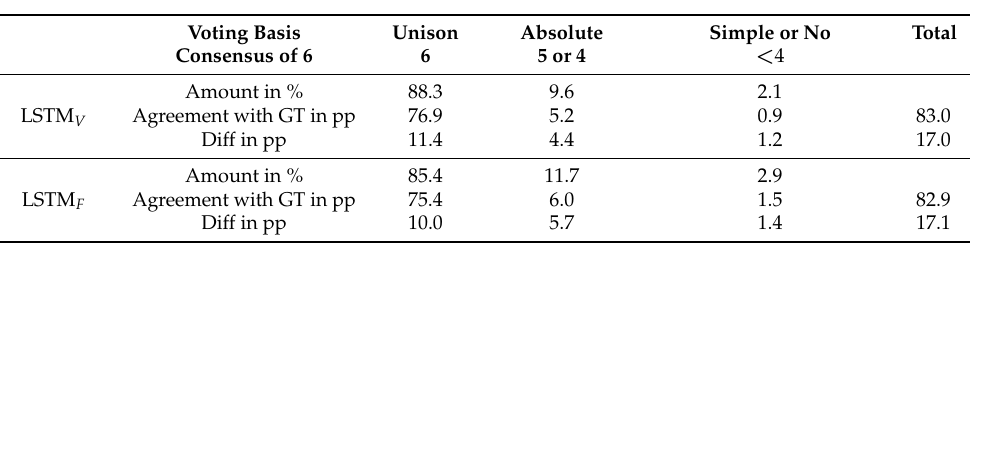
Table 4. Statistics on classifications’ majority vote of six time sequences from 2018. For both the variable and fixed training sequence approach, we list how many pixels are classified in unison, by an absolute majority, or without a